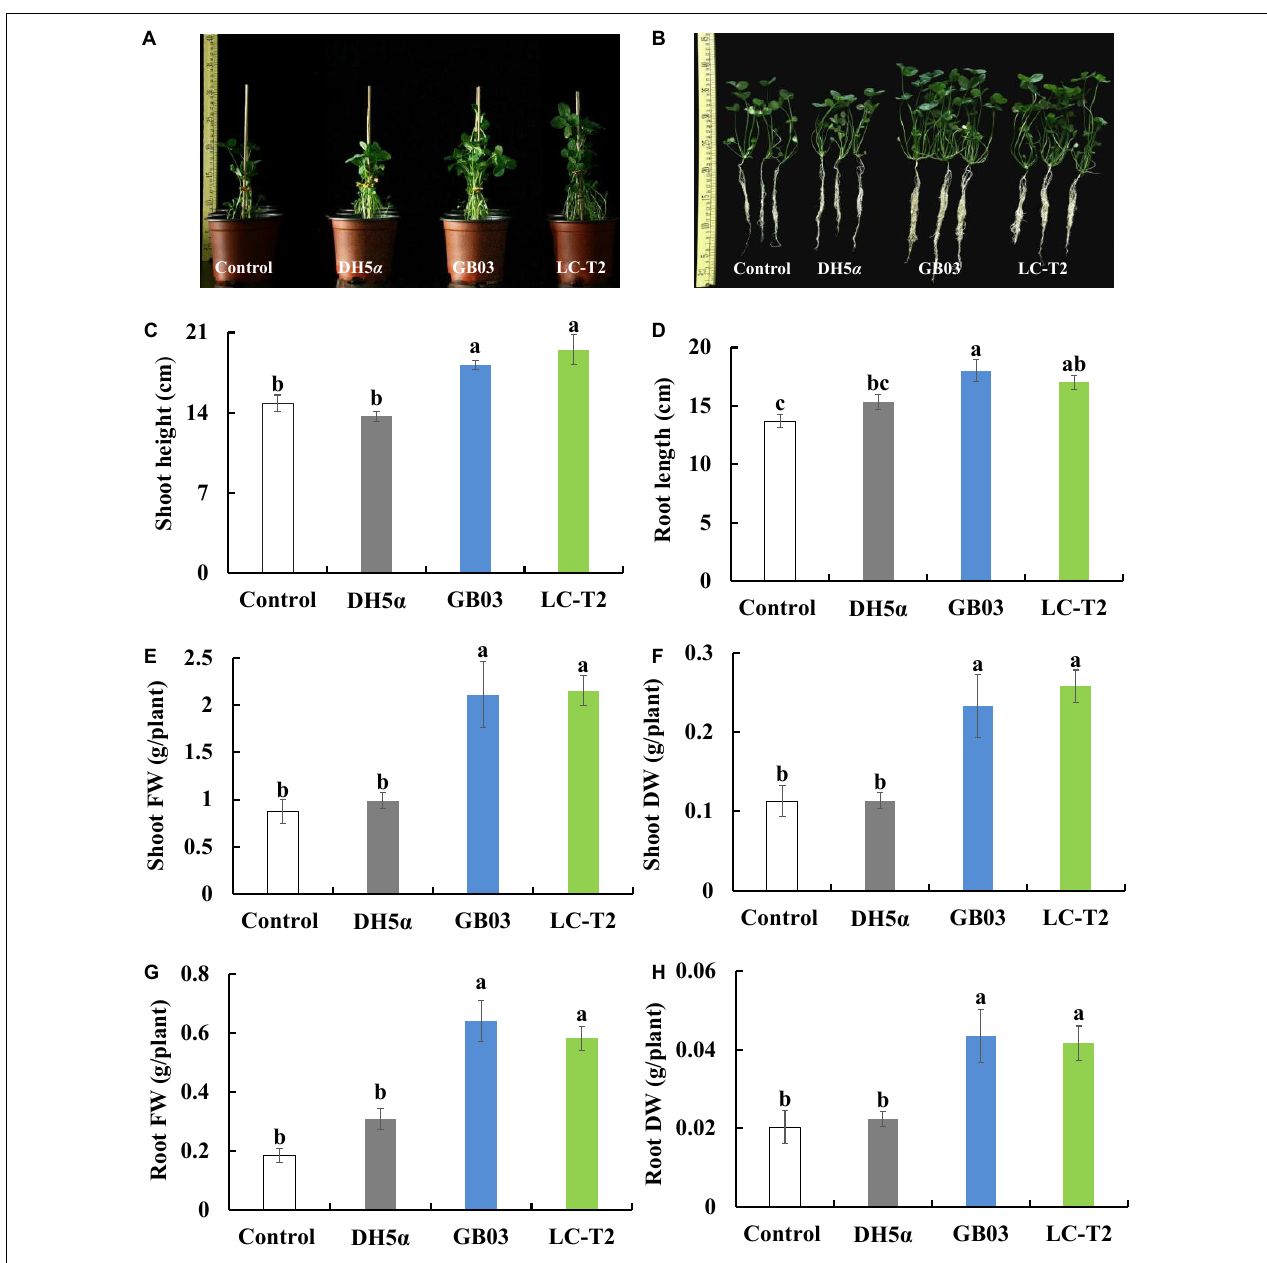
FIGURE 4 | Effects of LC-T2 T inoculation on seedling growth of white clover. Escherichia coli (DH5 α ) and Bacillus amyloliquefaciens (GB03) as positive control. (A,B) whole plant image, (C) shoot height, (D) root length, (E) shoot fresh weight, (F) shoot dry weight, (G) root fresh weight, and (H) root dry weight. Seedlings were taken image and biomass were measured after 30 days inoculate to bacterials suspension and double-sterile distilled water (DDW), respectively. Values are means and bars indicate SDs ( n = 6). Columns with different letters indicate significant difference at P < 0.05 (Duncan test).